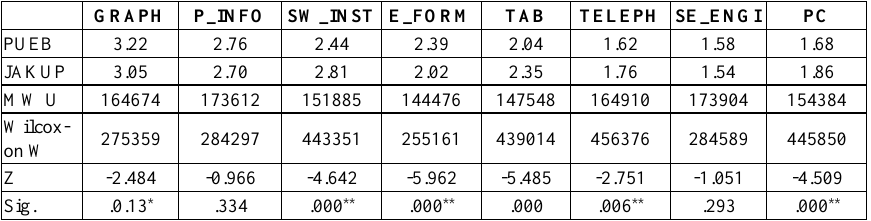
Table 5. Dependence of digital literacy on specialization of the higher education institution GRAPH